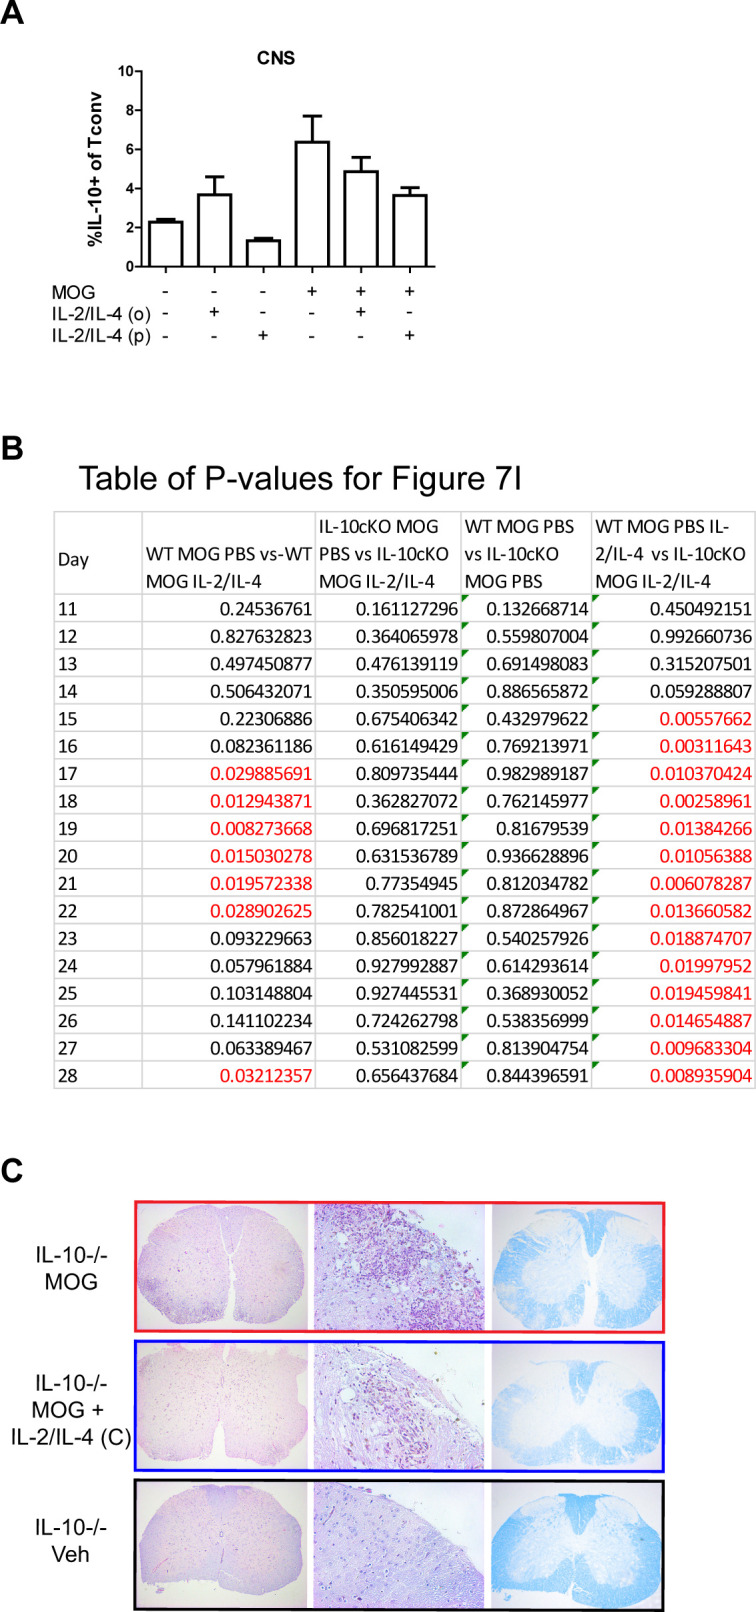
IL-10 is critical for suppression of experimental autoimmune encephalomyelitis (EAE) by IL-2/IL-4.(A) Analysis of IL-10 expression in CNS FoxP3- Tconv cells of Foxp3RFP/Il10GFP mice in the EAE trials by flow cytometry. N = 3. (B) Table of p-values for Figure 7I. Red font represents p≤0.05. Black font represents p>0.05. N = 10–12 for EAE mice, N = 4 for vehicle control mice. Related to Figure 7I. (C) Analysis of disease in the Il10-/- mice through FFPE-processed spinal cords undergoing H and E or LFB staining. Images represent a mouse of the mean disease score of each condition. N = 7–8 for EAE mice, N = 4 for vehicle control mice. Related to Figure 7K.